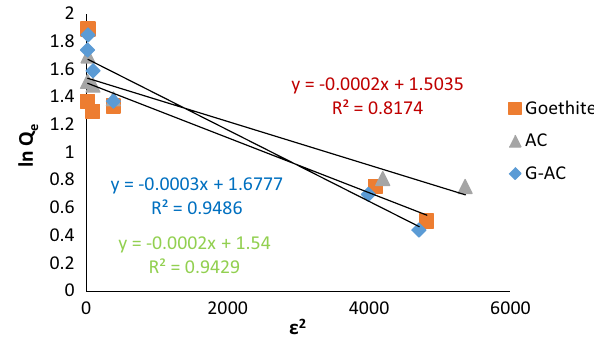
Fig. 12 Dubinin–Radushkevich isotherm plot Cr(VI) on G, AC and